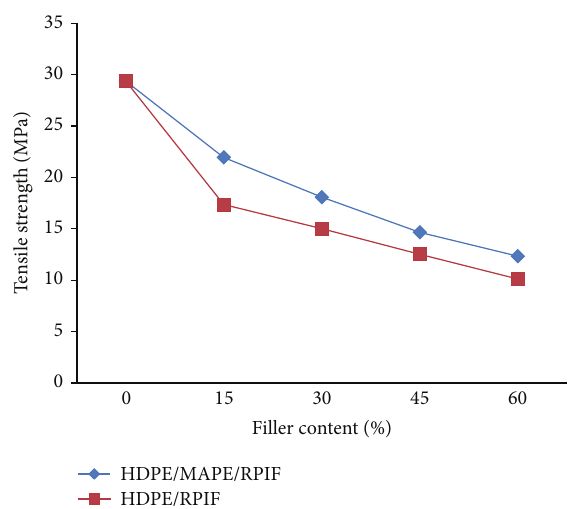
Figure 3: Effect of RPIF on Young’s modulus of RPIF/HDPE composites.